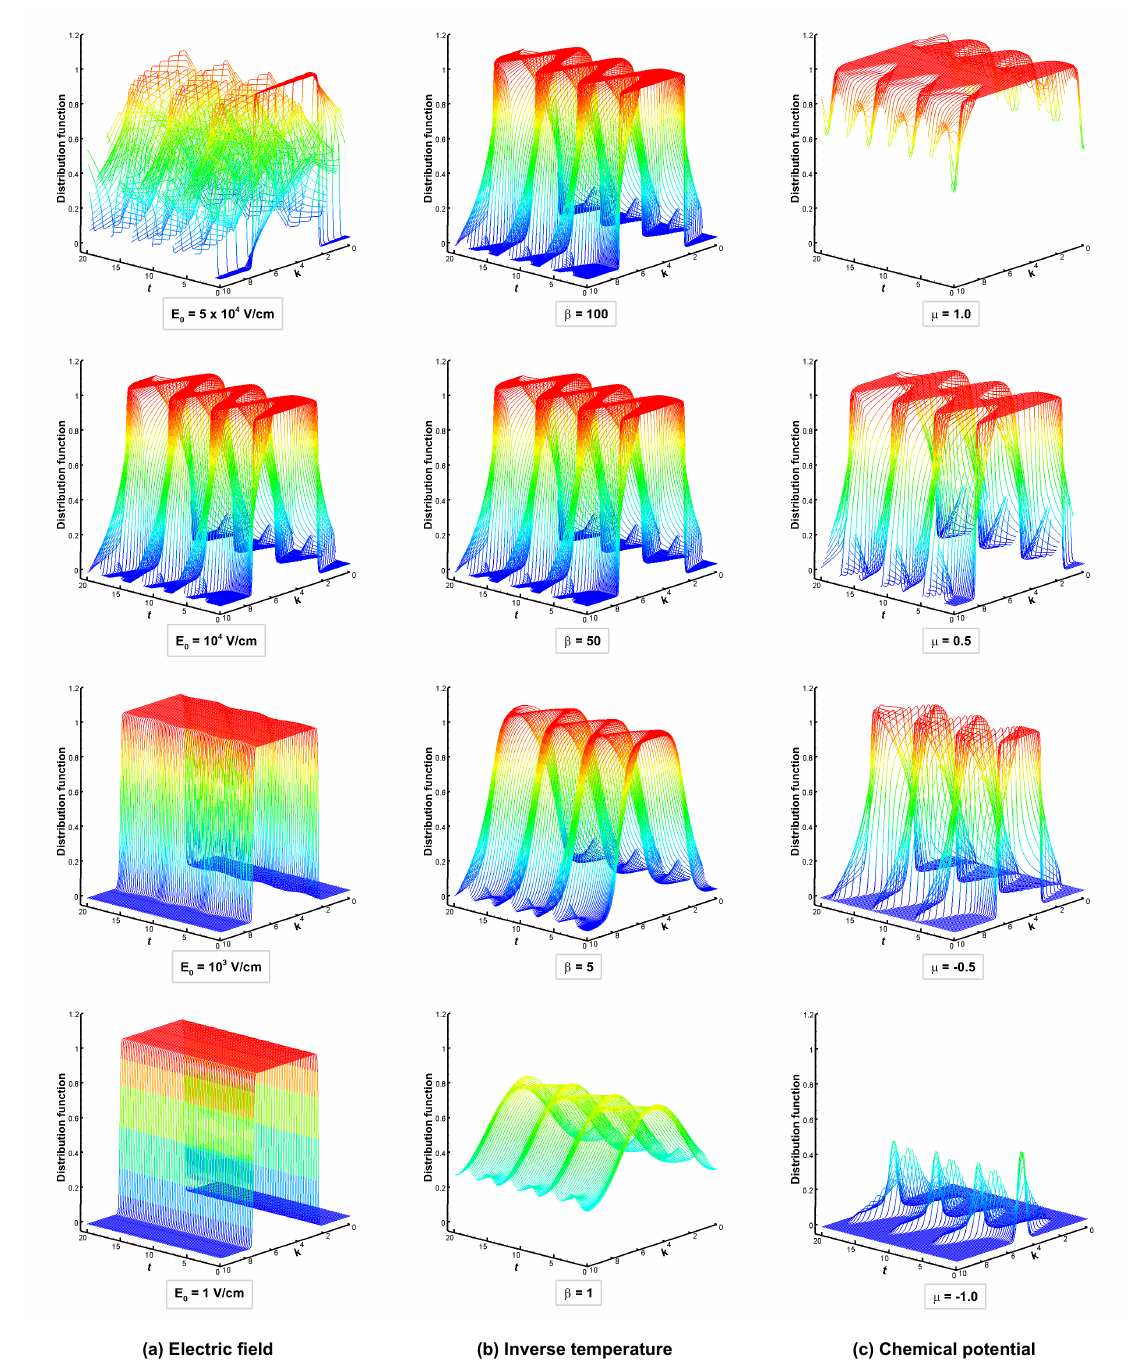
Figure 4. Effect of flow parameters on Boltzmann transport equation (BTE) dynamics: time evolution of distribution function at ( a ) electric field E 0 = 1,10 3 ,10 4 ,5 × 10 4 V/cm with τ = 1.0, β = 50, µ = 0, and ω = 1; ( b ) inverse temperature β = 1,5,50,100 with E 0 = 10 4 V/cm, τ = 1.0, µ = 0, and ω = 1; ( c ) chemical potential µ = − 1.0, − 0.5,0.5,1.0 with E 0 = 10 4 V/cm, τ = 1.0, β = 50, and ω =